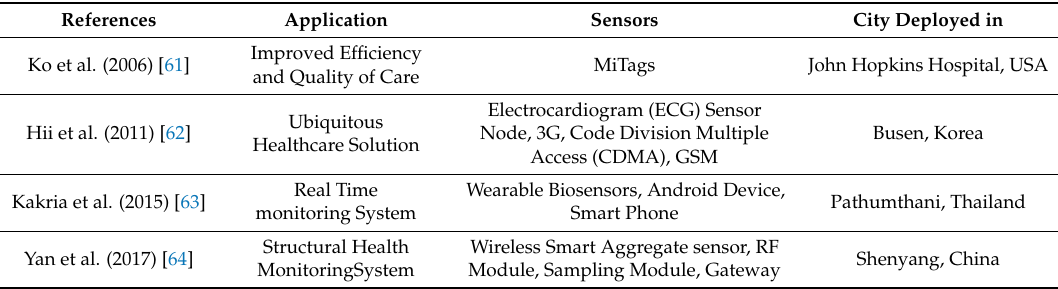
Table 8. Examples of prototyped applications for health. ECG: Electrocardiogram; CDMA: Code Division Multiple